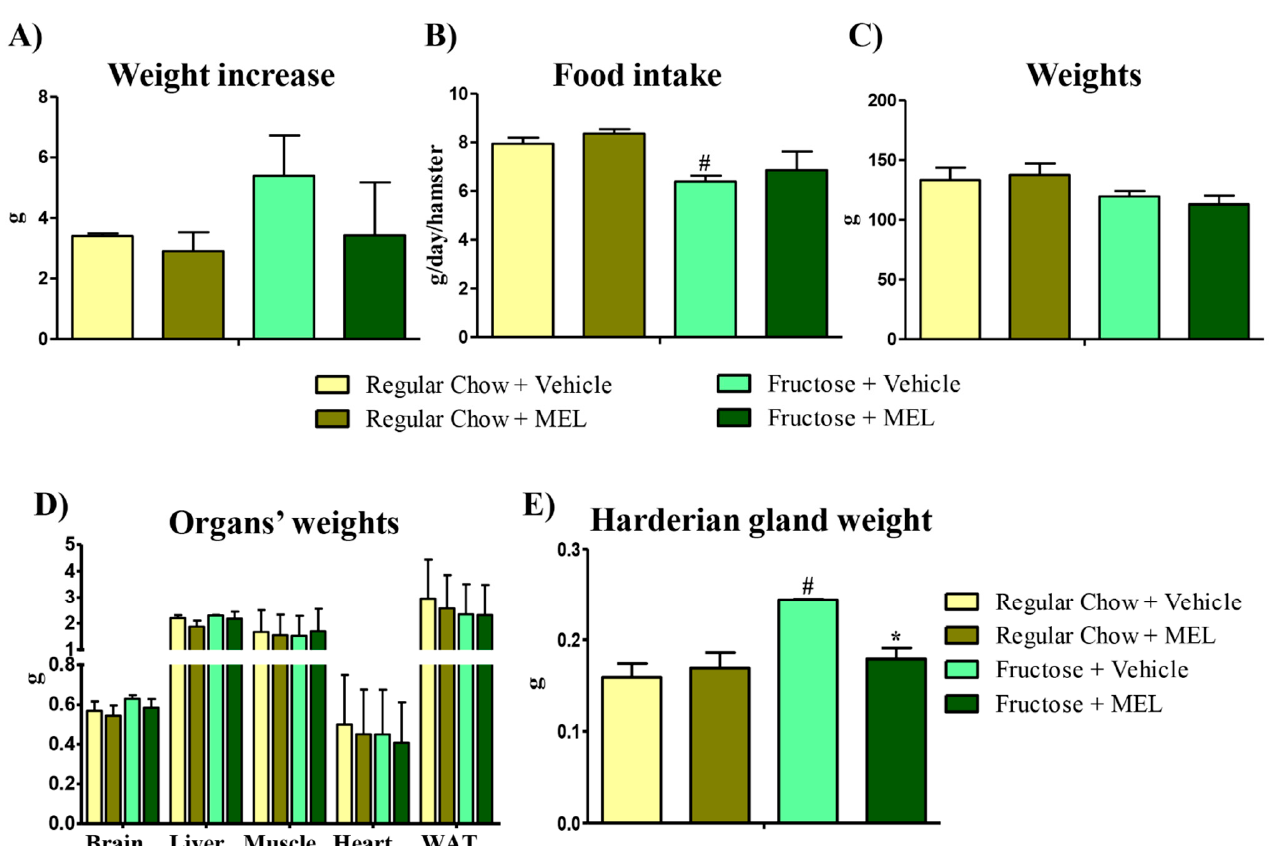
Figure 2. The Harderian gland is the organ most affected by a fructose diet. ( A ) Weight increase in grams of the hamsters fed with regular chow or fructose with or without melatonin treatment (25 µ g of melatonin for 15 days). ( B ) Food intake measure in grams per day and hamster from all the above conditions. ( C ) Total weights in grams of all groups. ( D ) Different organs and ( E ) the Harderian gland weights in grams, from all the above conditions. Bars are mean ± SEM. * p < 0.05 (differences caused by melatonin treatment) and # p < 0.05 (differences caused by diet).